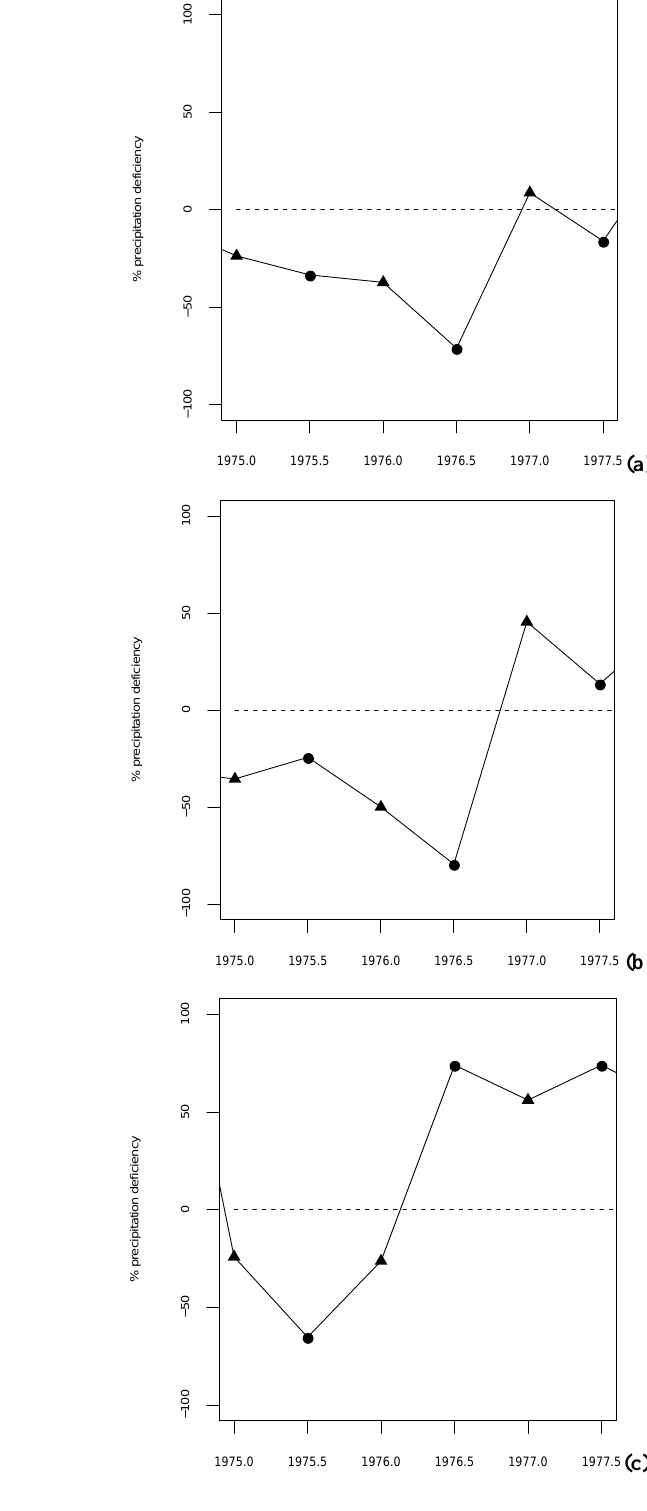
Fig. 4. Seasonally-adjusted and IB-corrected MSL time series (dashed line) and lowess trend (solid line). (a) Newlyn, (b) Brest and (c) Cascais.